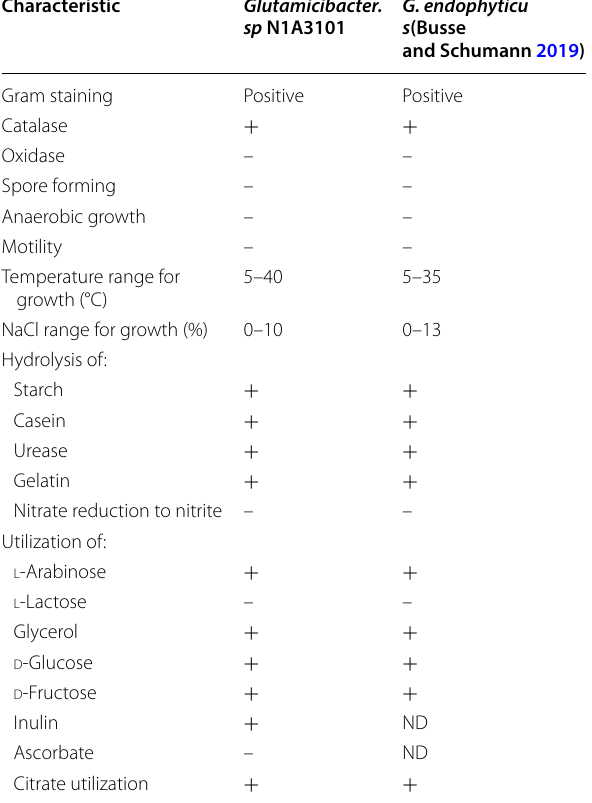
Table 1 Comparison of physicochemical characteristics of strain N1A3101 and its closest phylogenetic strain Characteristic